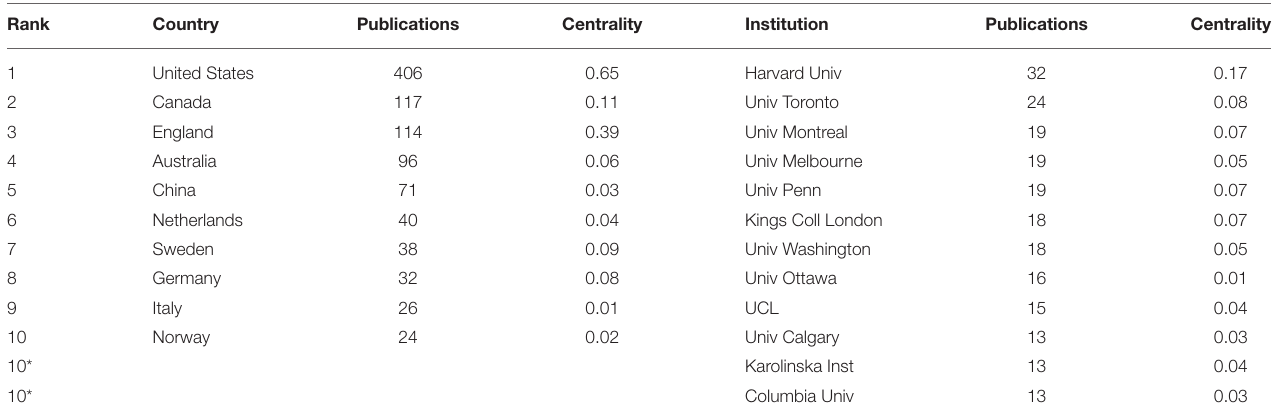
TABLE 1 | Ranking of top 10 countries and institutions in the field of exercise-depression-teenager research from 2000 to 2020. Rank Country